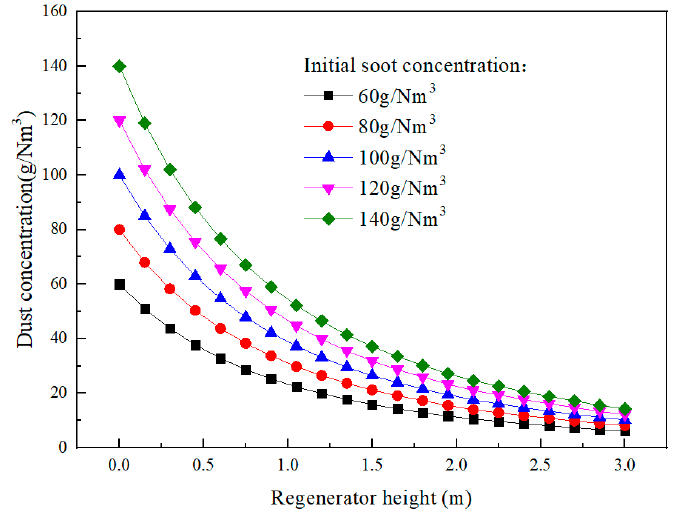
Figure 6. Change curves of different initial concentrations of dust.